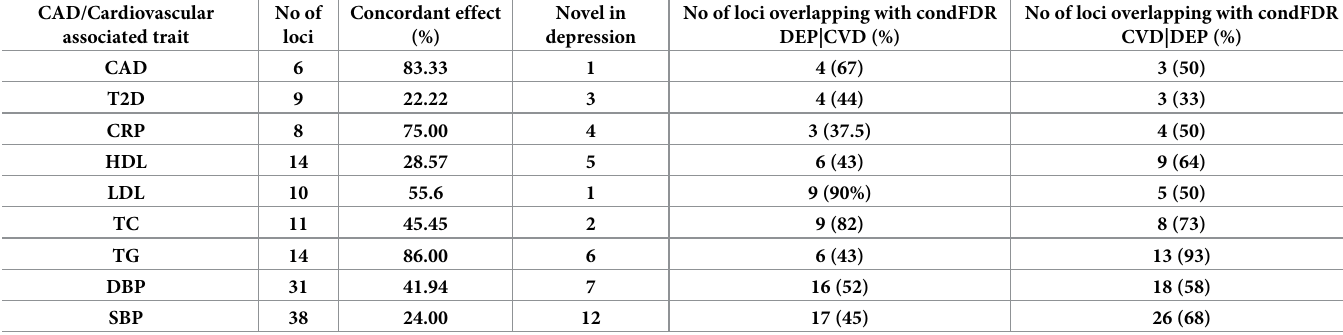
Table 1. Number if distinct genomic loci jointly associated with depression and CAD and CVD risk factors, the effect directions and the number of novel loci for depression. CAD; coronary artery disease, T2D; type 2 diabetes, CRP; c-reactive protein, HDL; high-density lipoprotein, LDL; low-density lipoprotein, TC; total choles- terol, TG; triglycerides, DBP; diastolic blood pressure, SBP; systolic blood pressure. CAD/Cardiovascular associated